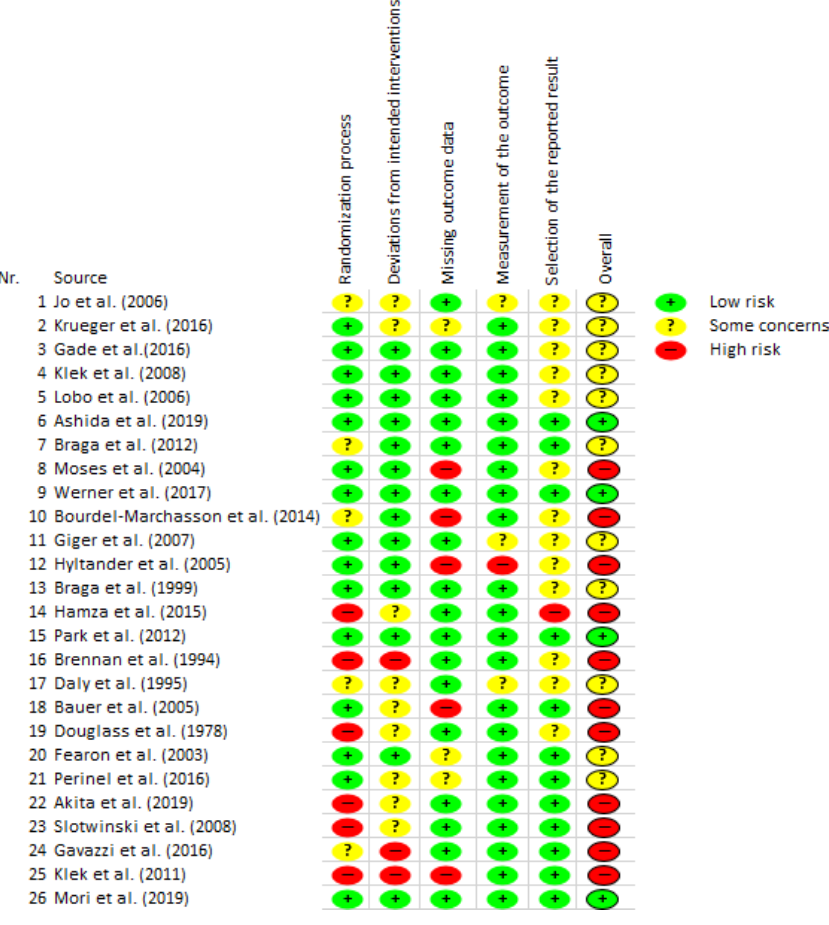
Figure 2. Risk of bias (RCTs via RoB2 by